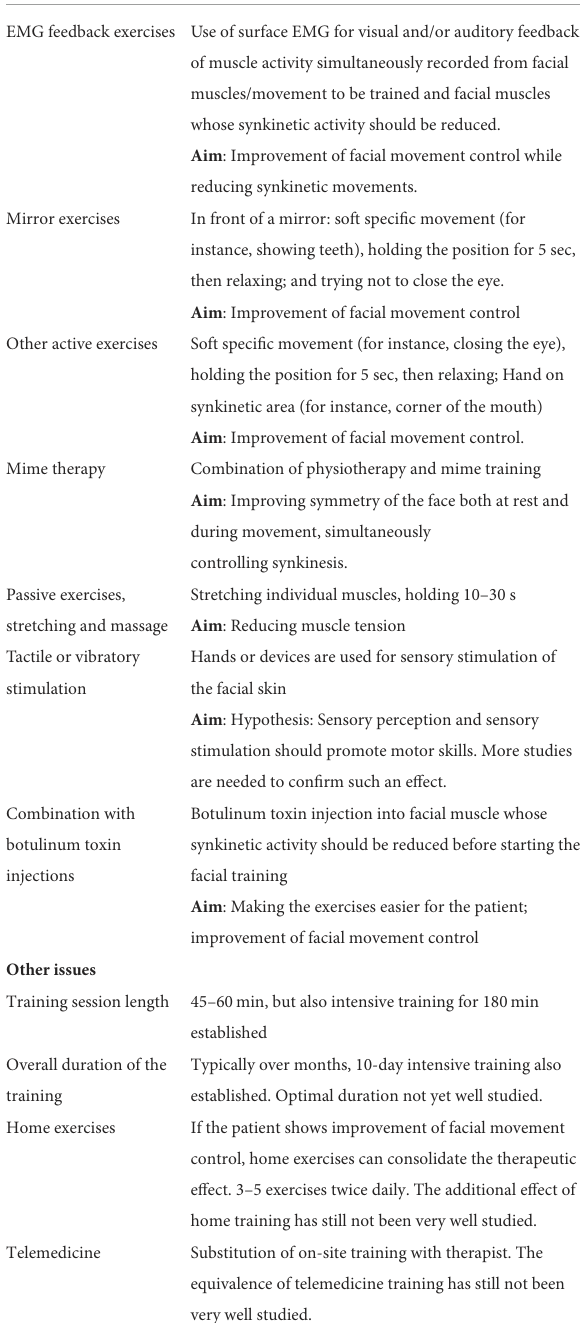
TABLE 4 Typical elements of facial training against facial synkinesis based on this